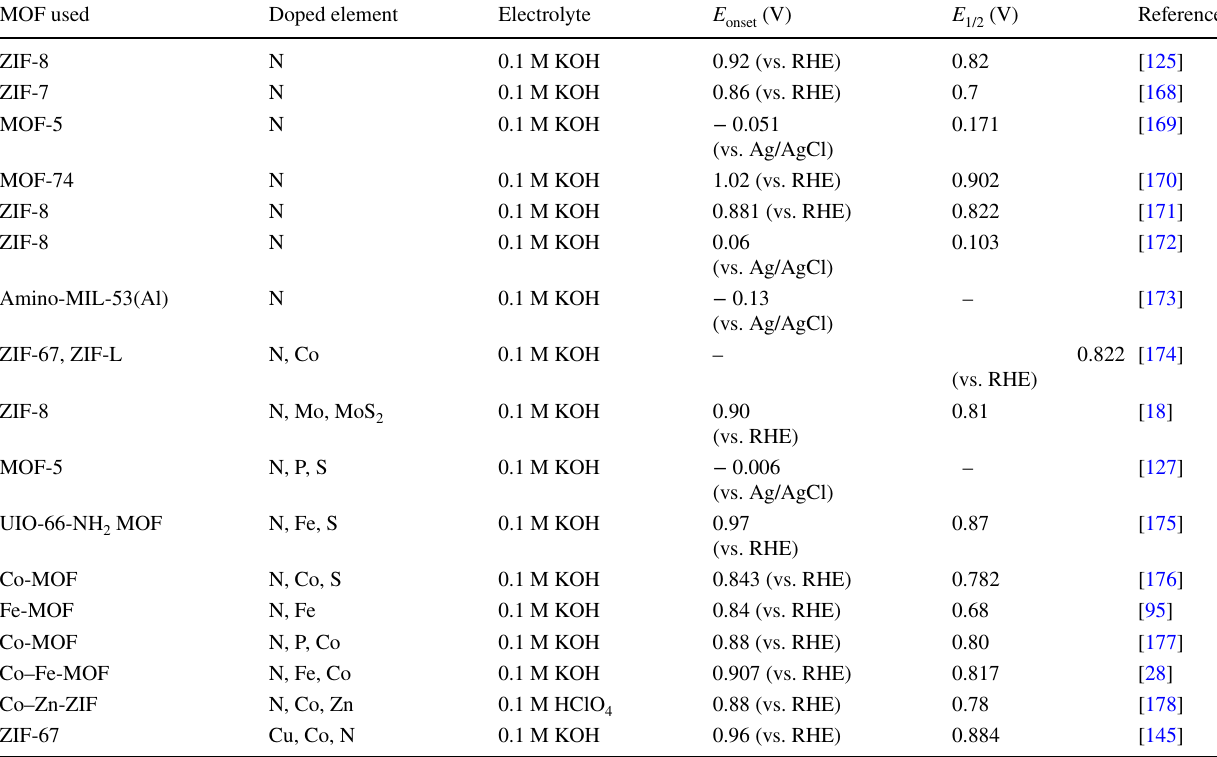
Table 2 Summary of the MOF-derived ORR electrocatalysts reported in recent studies MOF used